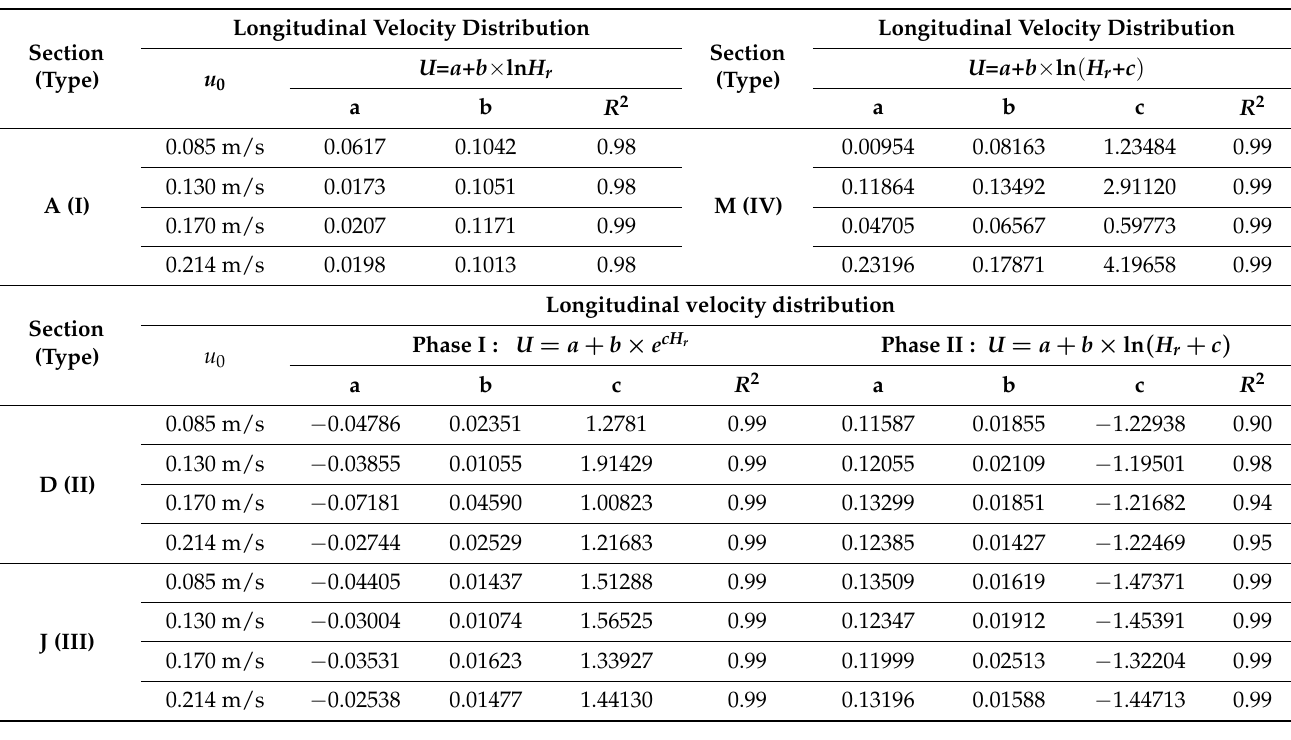
Table 2. Fitting results of longitudinal velocity distribution in some representative